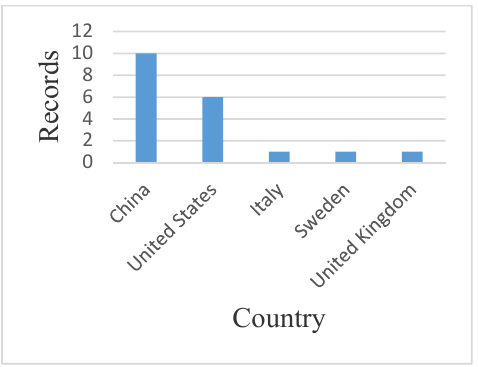
Figure 9. List of the top five countries in terms of published articles.